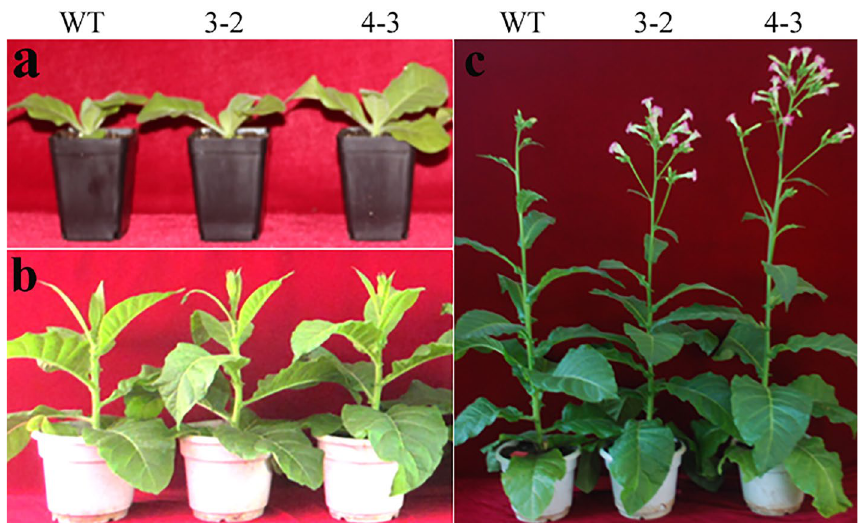
Figure 1. Phenotype of wild type and transgenic plants. ( a–c ) Phenotype of wild type and transgenic plants at seedling, bolting and flowering stages,